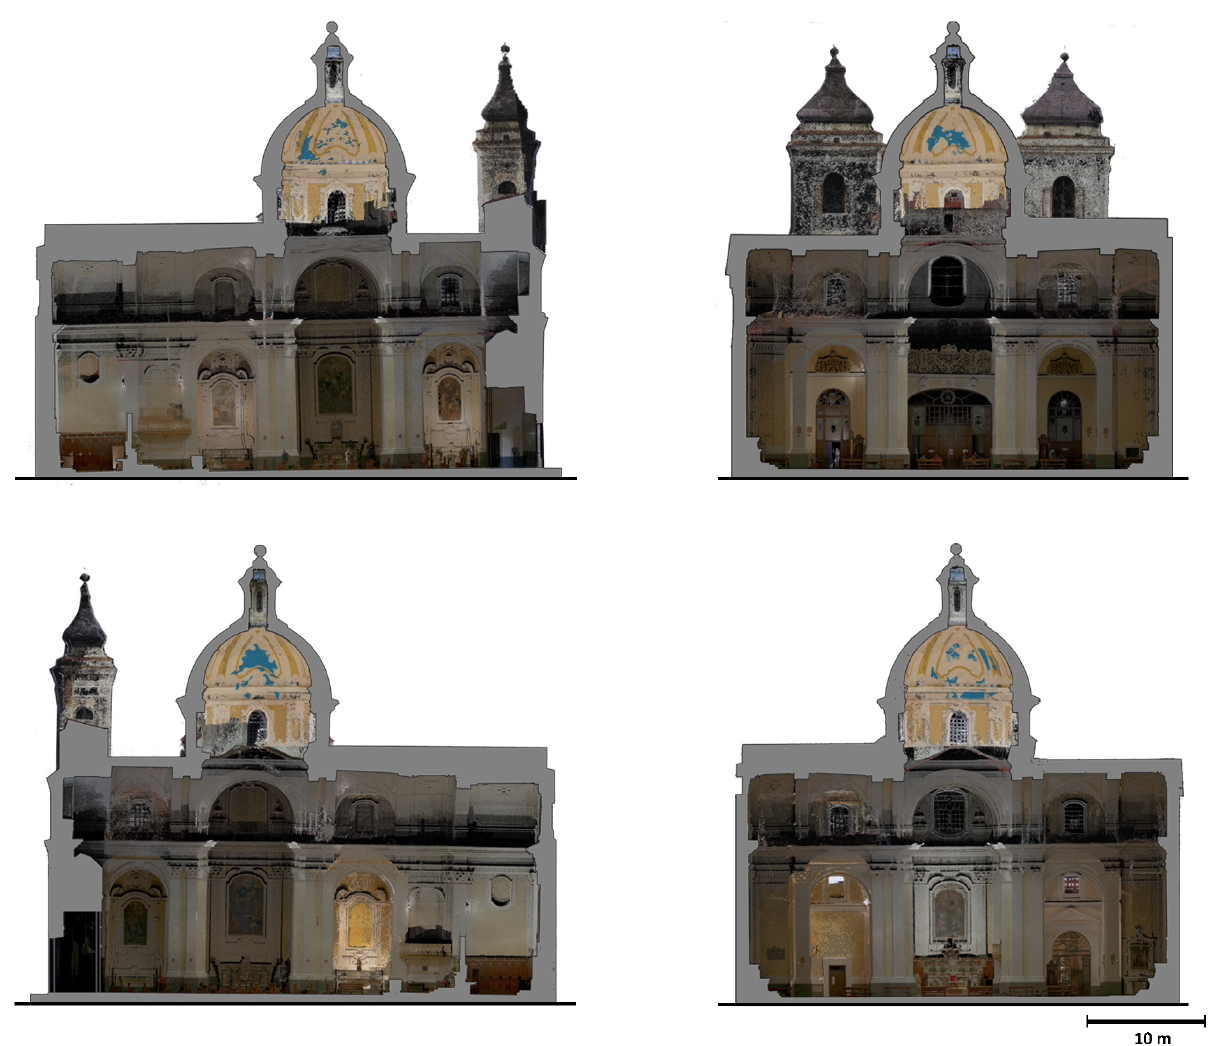
Figure 4. Sections of the C hurch with some moisture stains of the dome highlighted in blue: South longitudinal section, West cross section, North longitudinal section and East cross